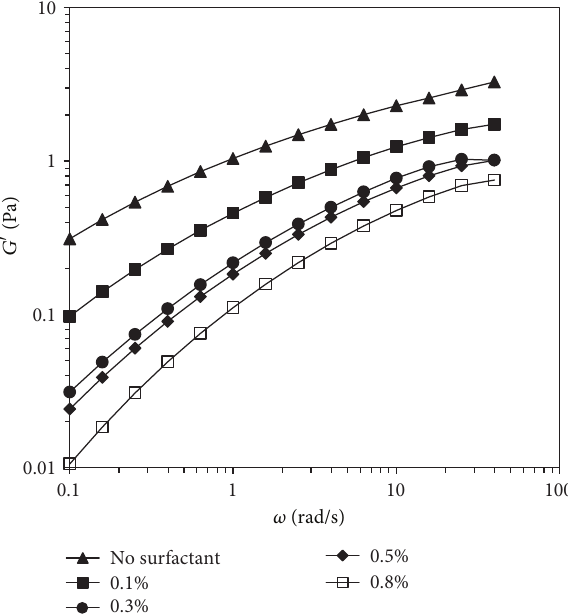
Figure 3: Effect of surfactant concentration on storage modulus of copolymer at different frequencies in deionized water at 50 ∘